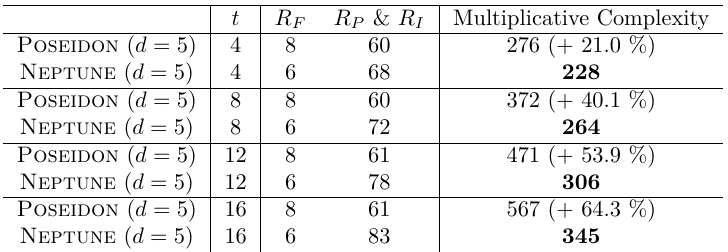
Table 2: Comparison between Poseidon and Neptune – both instantiated with d = 5 – for the case p ≈ 2 256 , κ = 128, and several values of t ∈ { 4 , 8 , 12 , 16 } . t R F R P & R